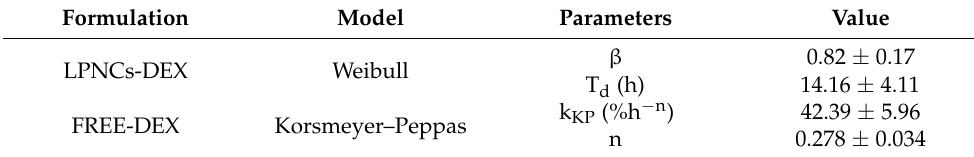
Table 7. Individual modelling and parameters for the LPNCs and FREE DEX release